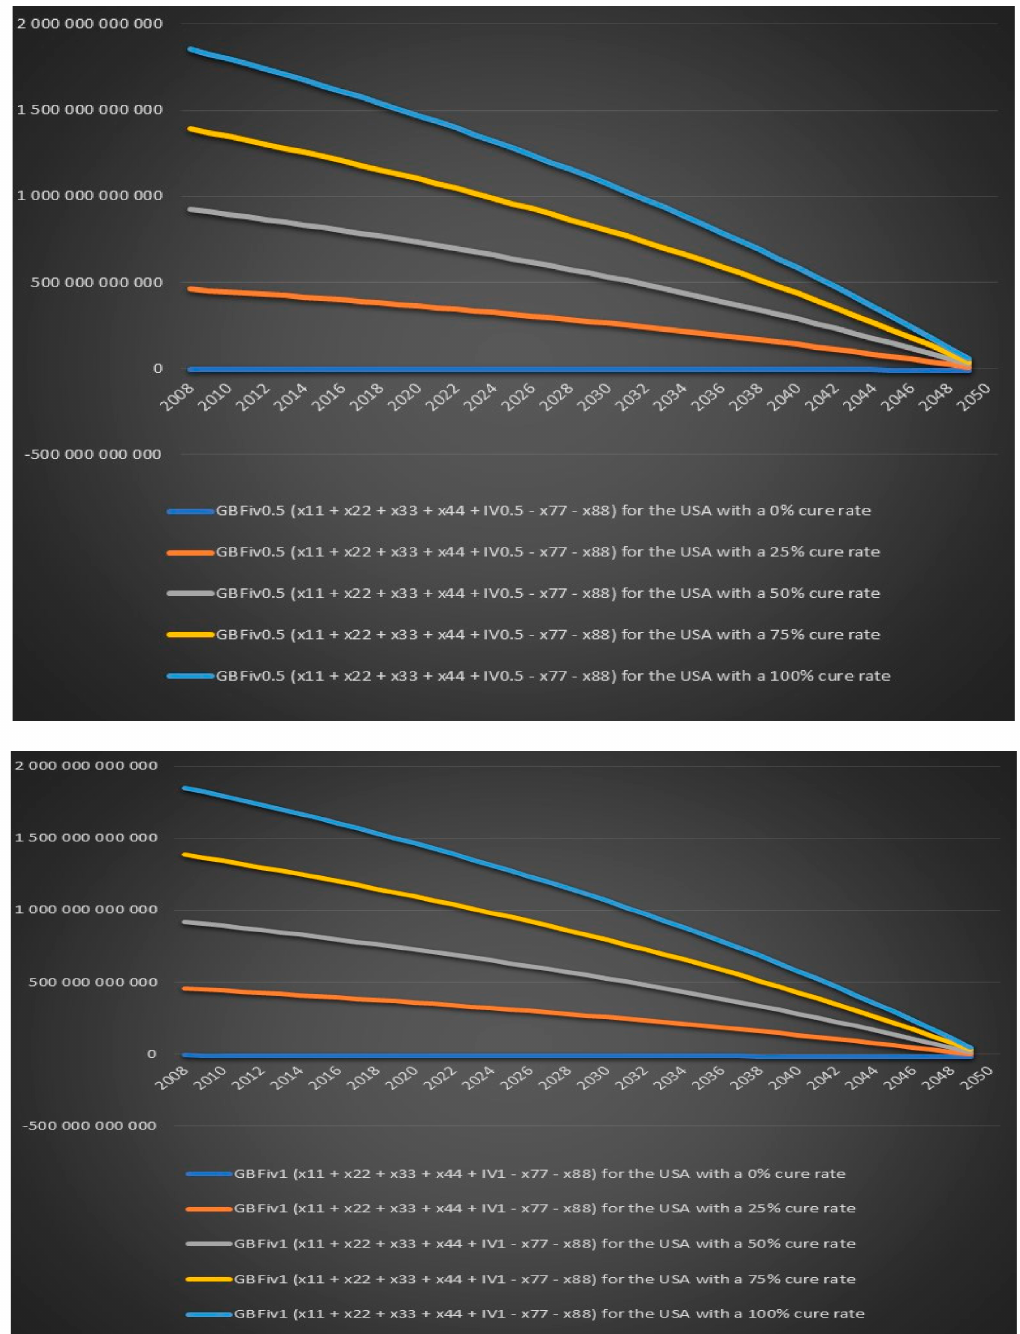
Figure 20. Future government costs and revenues in the USA over